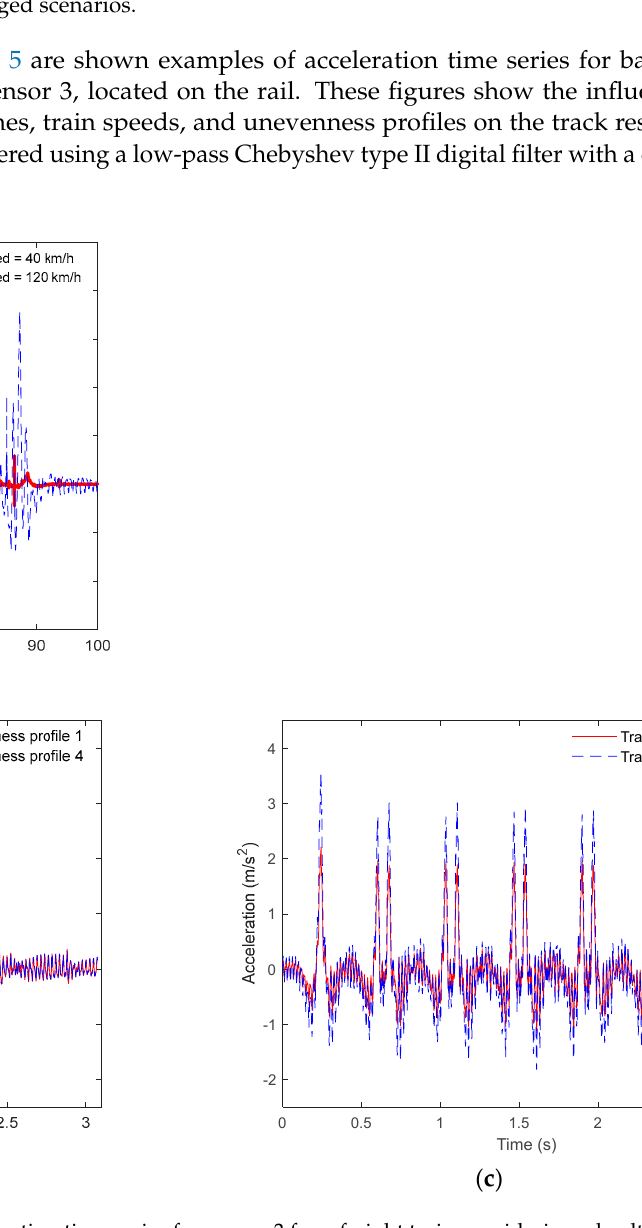
Figure 4. Damaged scenarios.